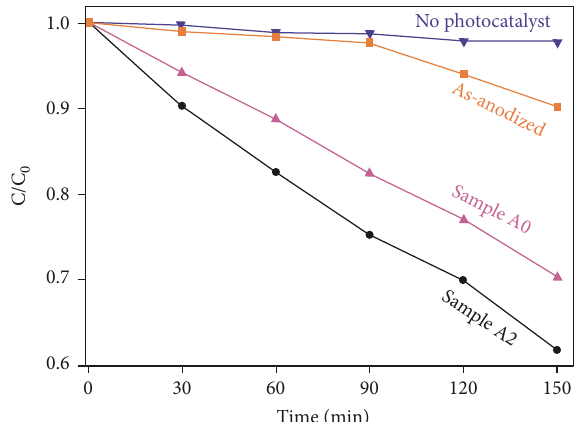
Figure 11: Ratio of the actual and initial concentrations (C/C ) of 0 rhodamine B as a function of the UV illumination time for the as- anodized sample (anodized at 80 V for 7200s), sample A0 (anodized at 80V for 7200 s, following by annealing at 450 ° C for 4h), and sample A2 (black TiO nanotubes converted from sample 2 A0 via the activation step and subsequent cathodic treatment). The blank experiment was carried out in the absence of any photocatalyst ( “ no photocatalyst ” ). Reprinted with permission from [91]. Copyright (2014) The Royal Society of